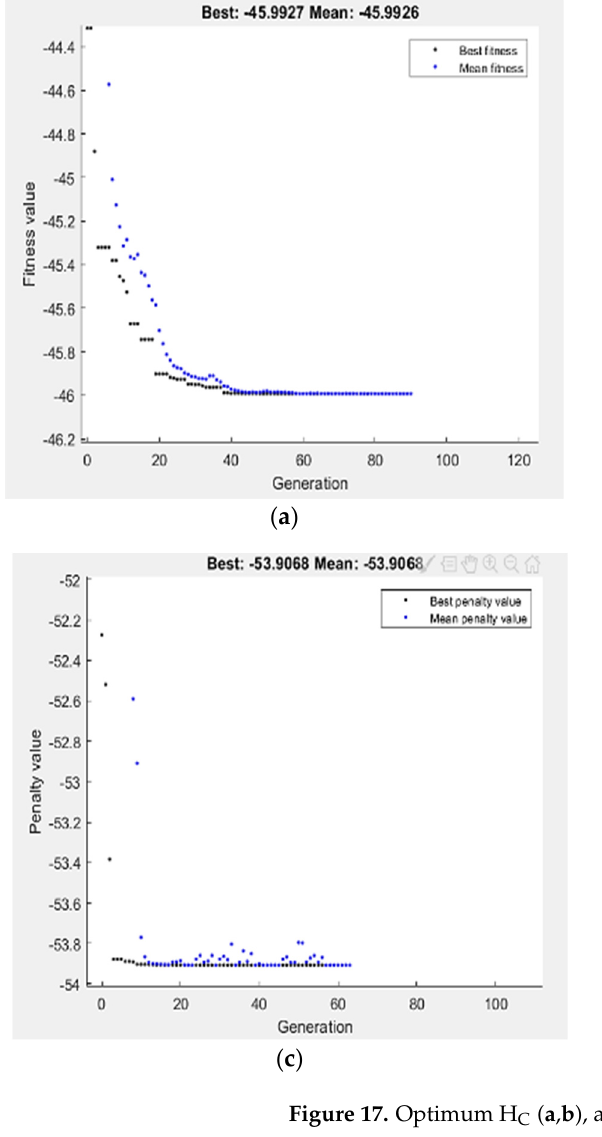
Table 5. Summary results of pure Mg ECAP